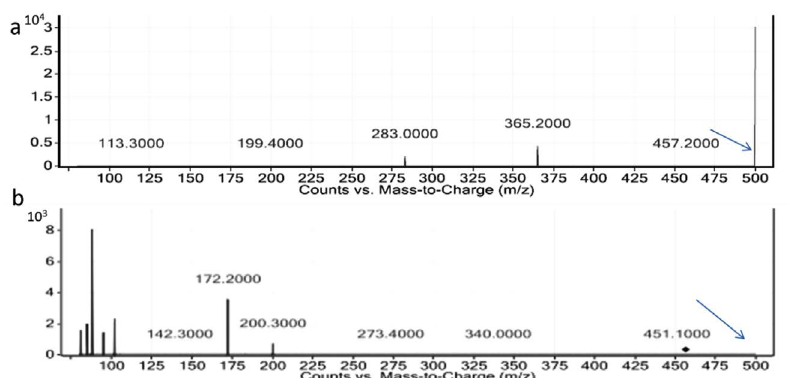
Fig. 3. LC-MS analysis of rhamnolipid of Pseudomonas aeruginosa a) Control b) grown with curcumin